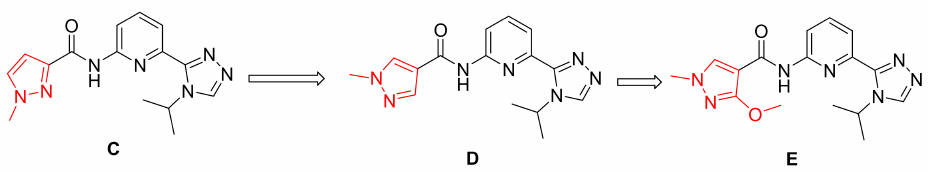
Figure 13. A scheme depicting compounds C , D , and E .